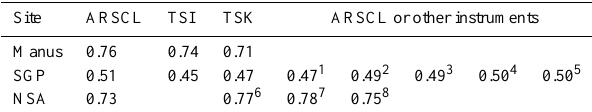
Table 2. Annual mean Total Cloud Fraction (TCF) over three